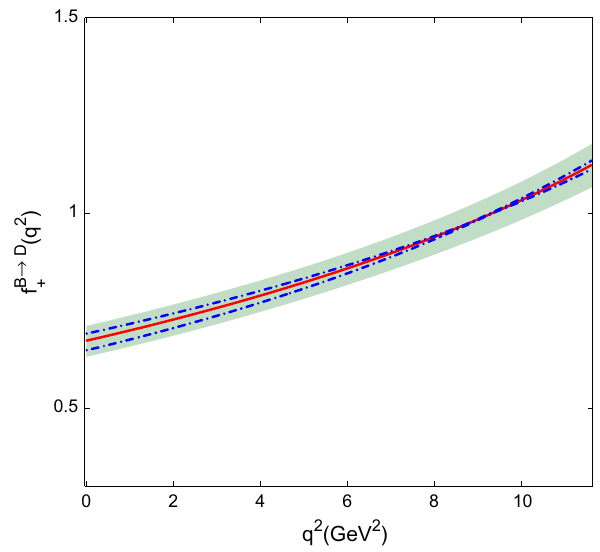
Fig. 7 The extrapolated TFF f B → D + ( q 2 ) versus q 2 . The solid line is the central value and the shaded band is the squared average of all the error sources. The error from the leading-twist DA φ 2 ; D is shown by the dash-dotted